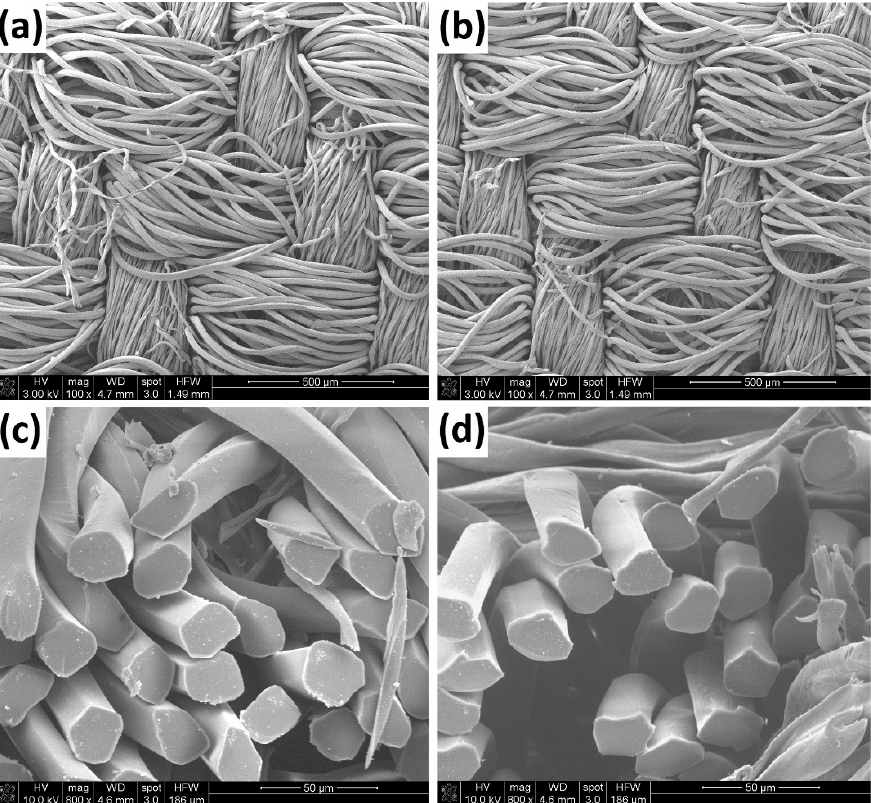
Figure 4. SEM images of Sample 4 (CO 70/PES 30): Woven fabric surface (magnification 100×): ( a ) before exposure; ( b ) after radiant heat exposure (10 kW·m − 2 , 40 s), Cross-section of yarn (magnification 800×): ( c ) before exposure; ( d ) after radiant heat exposure (10 kW·m − 2 , 40 s). Sample